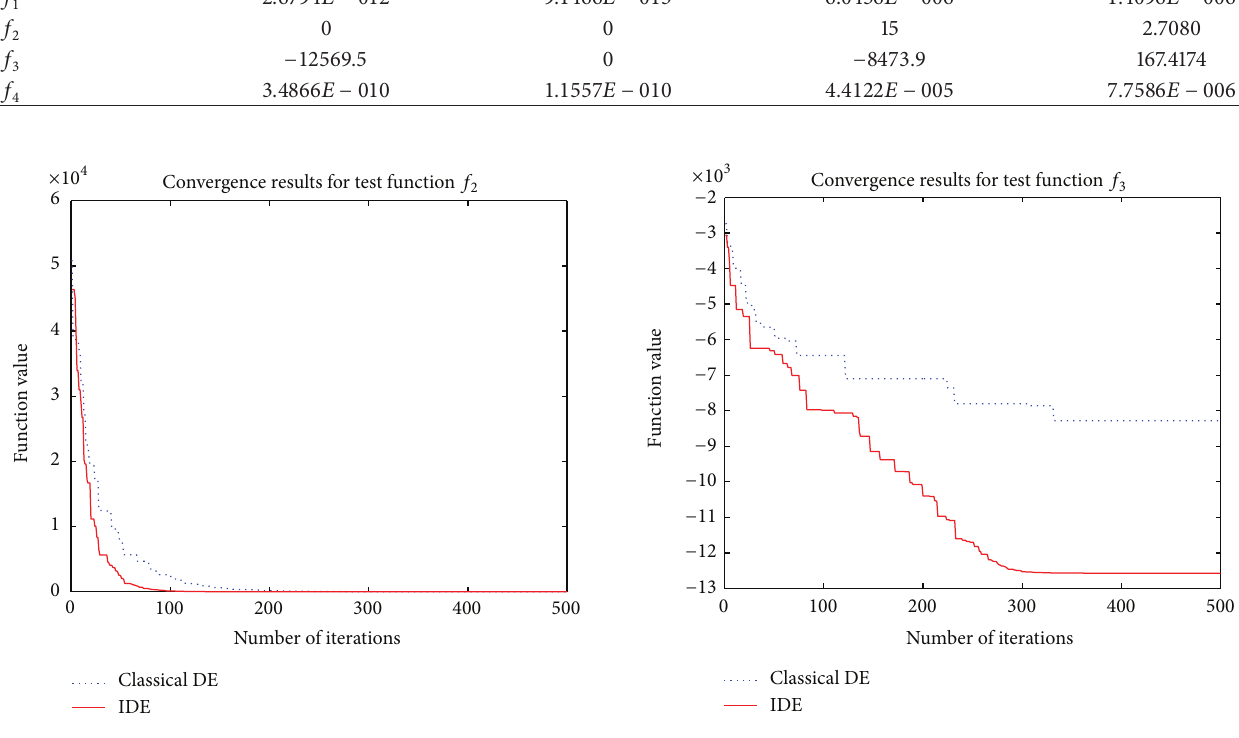
Figure 2: Convergence results of 𝑓 2 . Figure 3: Convergence results of 𝑓 3